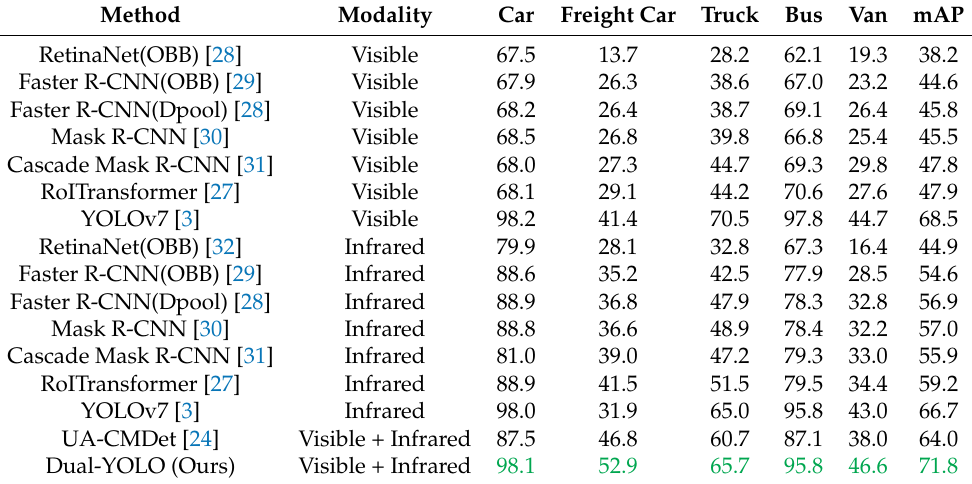
Table 4. Evaluation results on the DroneVehicle dataset. All values are in %.The top results are marked in